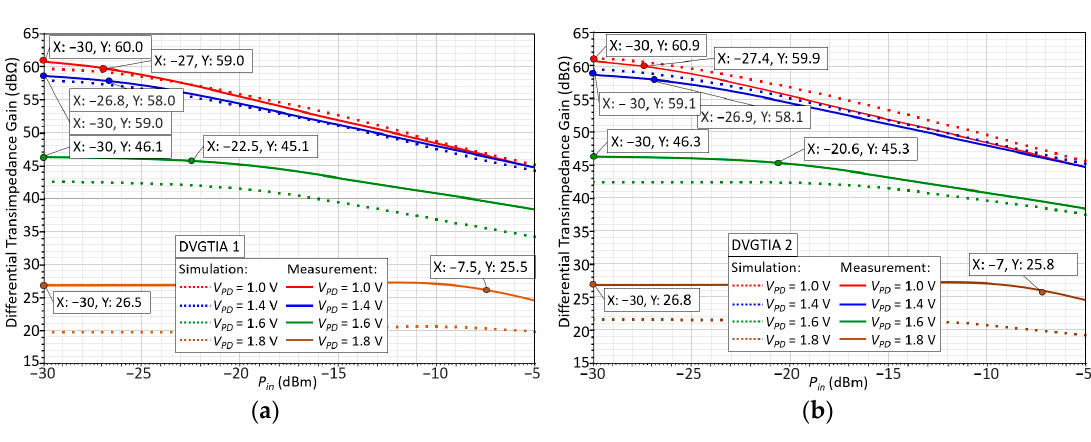
Figure 10. ( a ) Post-layout simulation and measured IP1dB compression curve of the DVGTIA design 1 and ( b ) DVGTIA design 2 with (cid:1848) (cid:3017)(cid:3005) at 1 V, 1.4 V, 1.6 V and 1.8 V .